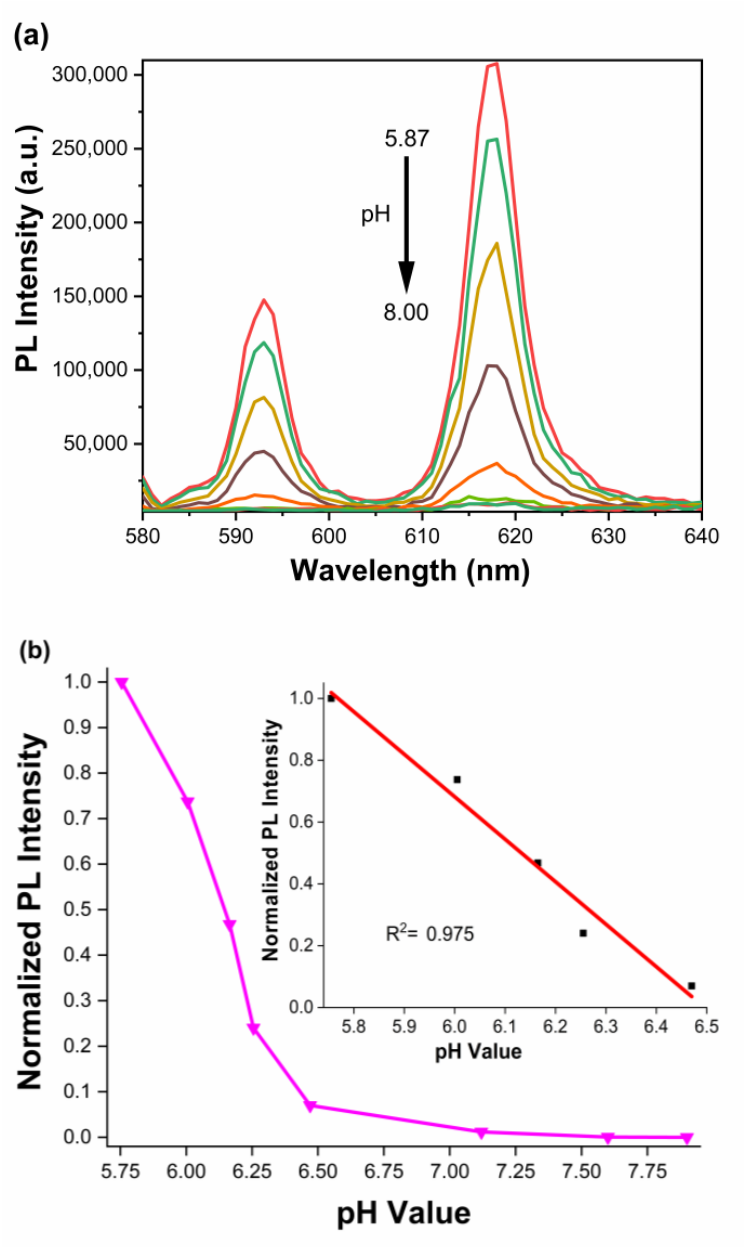
Figure 4. ( a ) PL spectra of K[Eu(hfa) 4 ] with different pH values from pH 5.87 to pH 8.0. ( b ) PL titra- tion at 618 nm at different pH, the inset shows the linear relationship from pH 8.8 to 6.5 with R 2 of